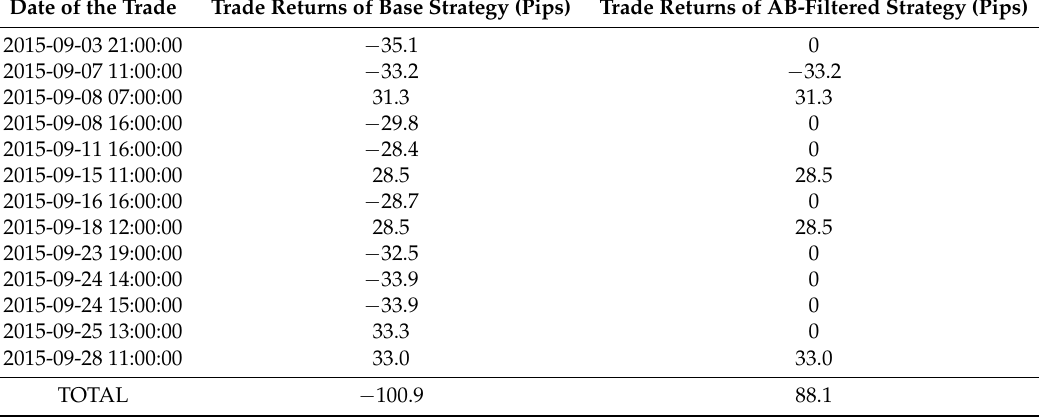
Table 2. Trade returns of an hourly timeframe trading strategy and its filtered version using AdaBoost classifier to learn which trades are profitable. Only the performance of the month of September is shown in this table. Figure 9 shows both equity curves for all the out-of-sample data. Notice how the AB-filtered strategy shows 0 for the returns of all those trades which were predicted to yield negative returns and a non-zero value for all those trades which were predicted to yield positive returns. It can be seen that the prediction is not always good, since there are negative predictions for true positive returns and